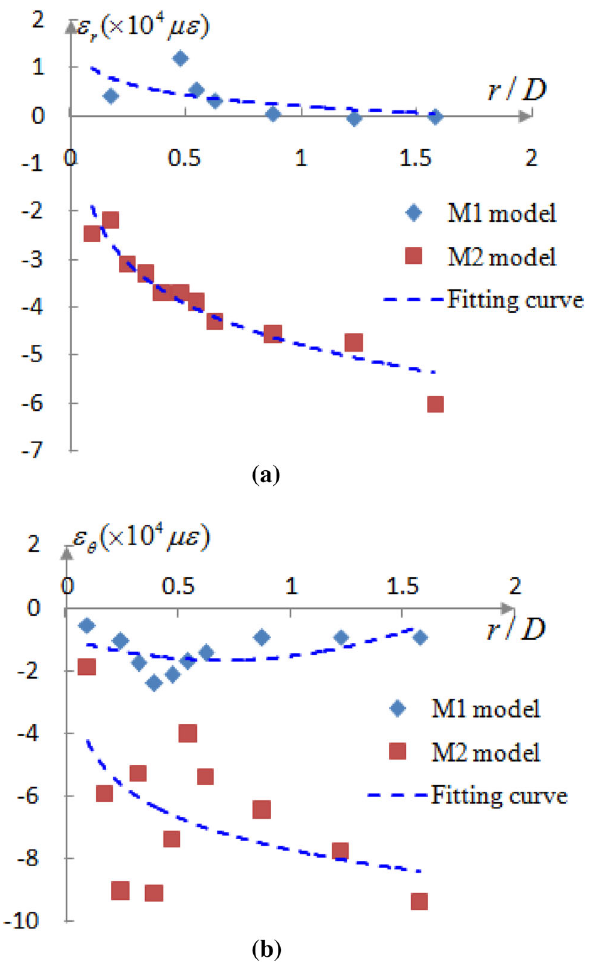
Fig. 15 a Radial and b circumferential strain curves in the middle part of the side walls in the M1 and M2 models under the maximum load